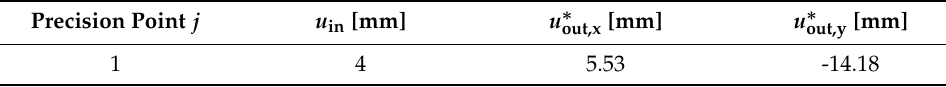
Figure 10. Problem definition for a compliant mechanism rib structure. Table 6. Precision points for the rib example.